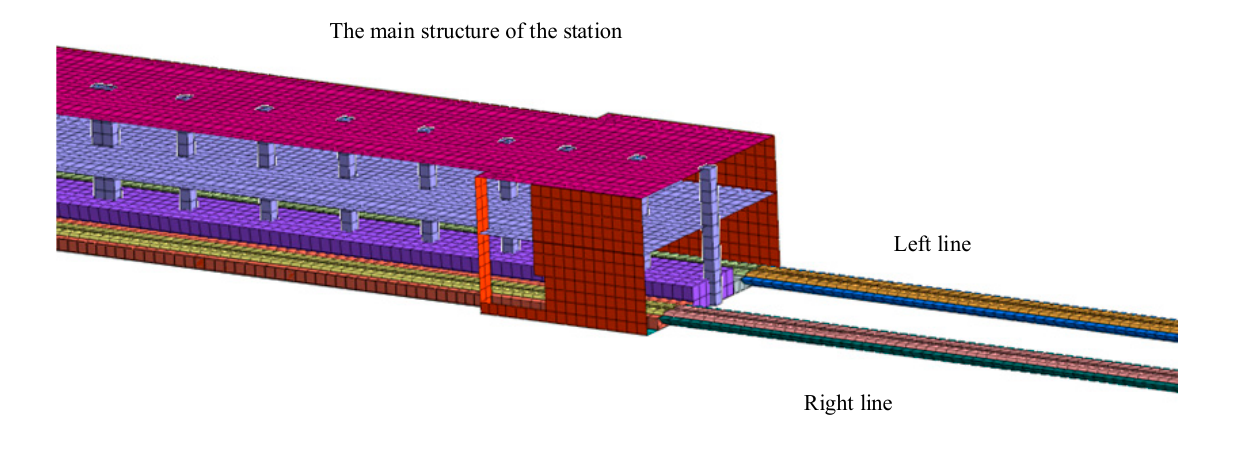
Figure 21. Schematic diagram of internal station simulation.